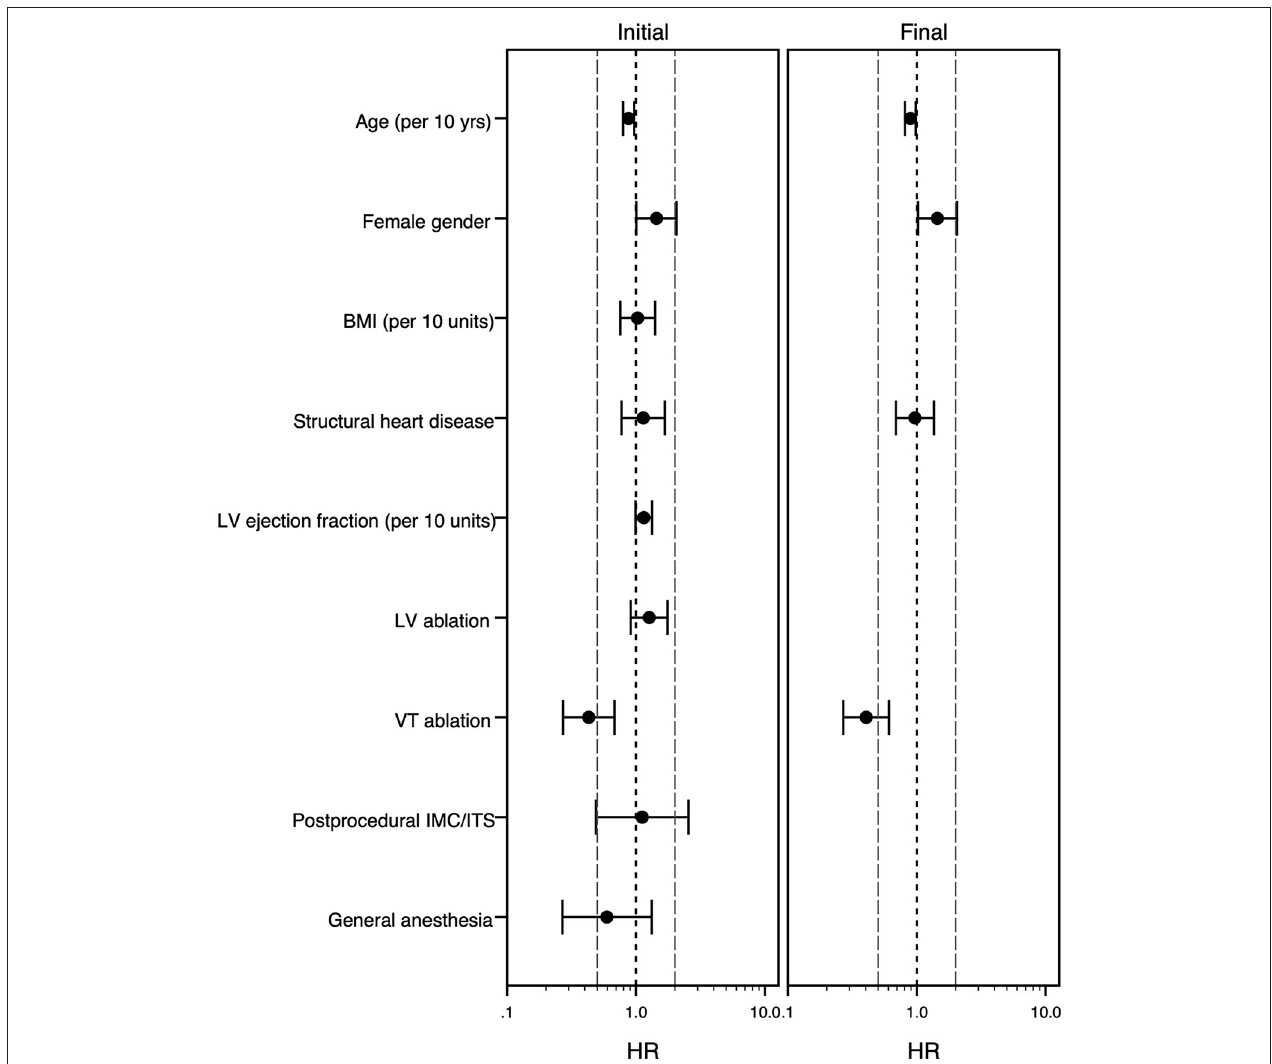
FIGURE 3 | Forest plot of the multivariable Cox model analyzing risk factors for longer hospital stay. The multivariable Cox-regression analysis is displayed. Hazard ratio < 1 stands for association with longer hospital stay, while hazard ratio > 1 goes along with shorter stay. The initial model (left panel) and final model (right panel) is shown. The grouping variable “structural heart disease” was forced into the model equations, all other covariates were selected following the forward-stepwise variable selection method. For age, body mass index and left ventricular ejection fraction the effect of an increase of 10 years/kg/m 2 /% is shown. Hazard ratios (point) with 95% confidence intervals (whiskers) are displayed. BMI, body mass index (kg/m 2 ); HR, hazard ratio; IMC/ITS, intermediate care unit/intensive care unit; LV indicates left ventricle; VT, ventricular tachycardia, yrs.,